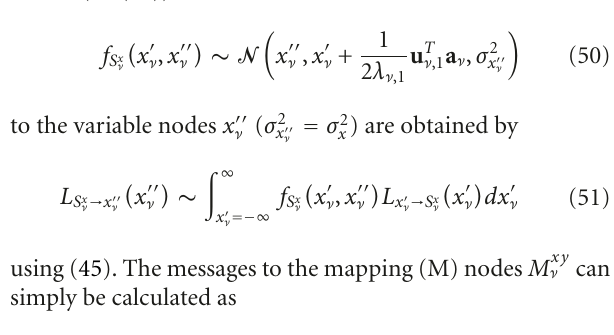
Figure 6: Example for the FG positioning algorithm with N BS = 3